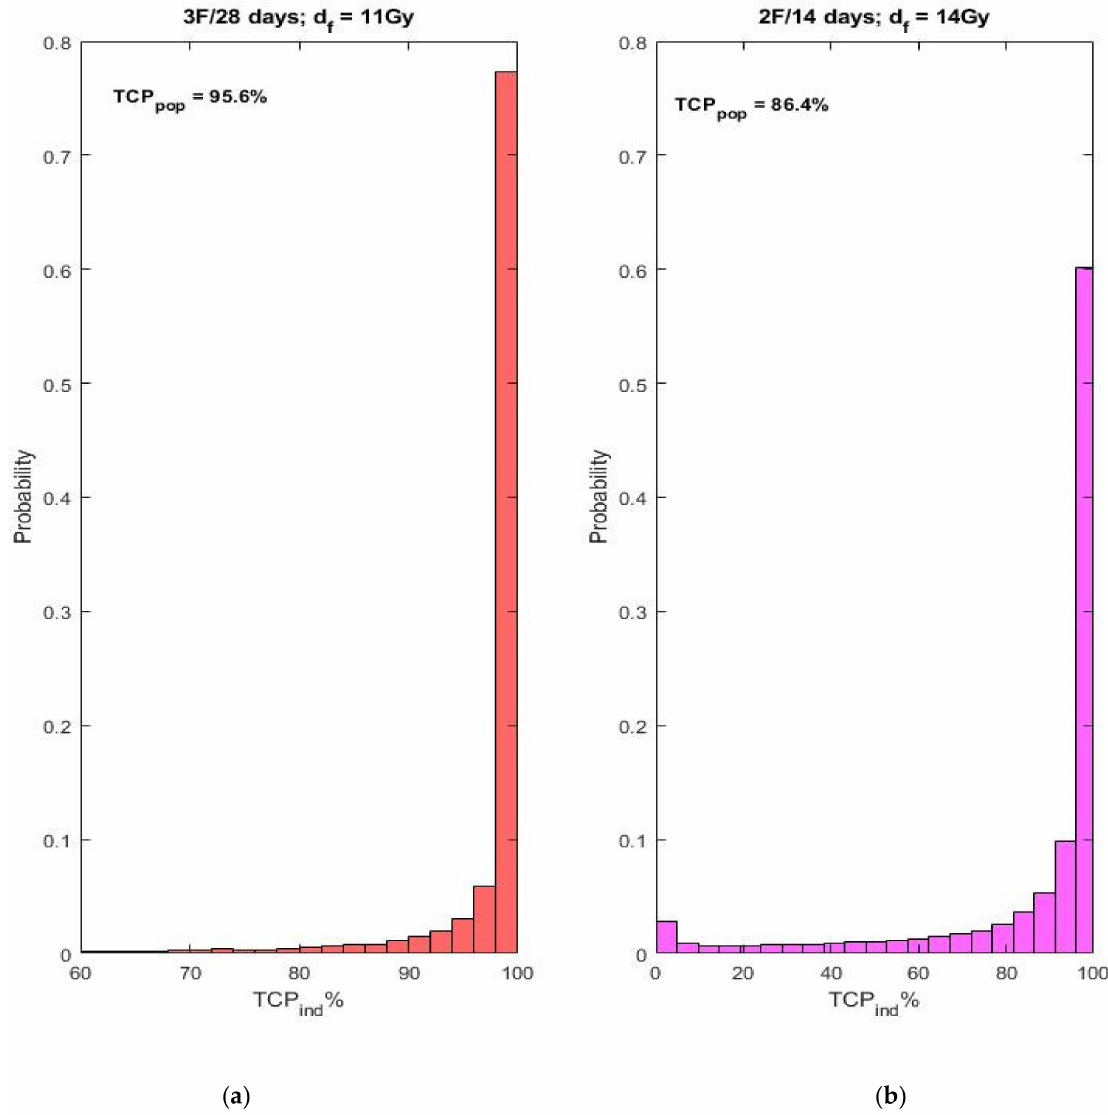
Figure 1. Individual TCP distributions obtained for the parameter values shown in Equations (6) and (7). ( a )—individual TCP distribution for the three-fraction regimen (5 failures out of 107 patients (4.7%) [25]); ( b )—individual TCP distribution for the two-fraction regimen (15 failures out of 103 patients (14.6%) as reported in